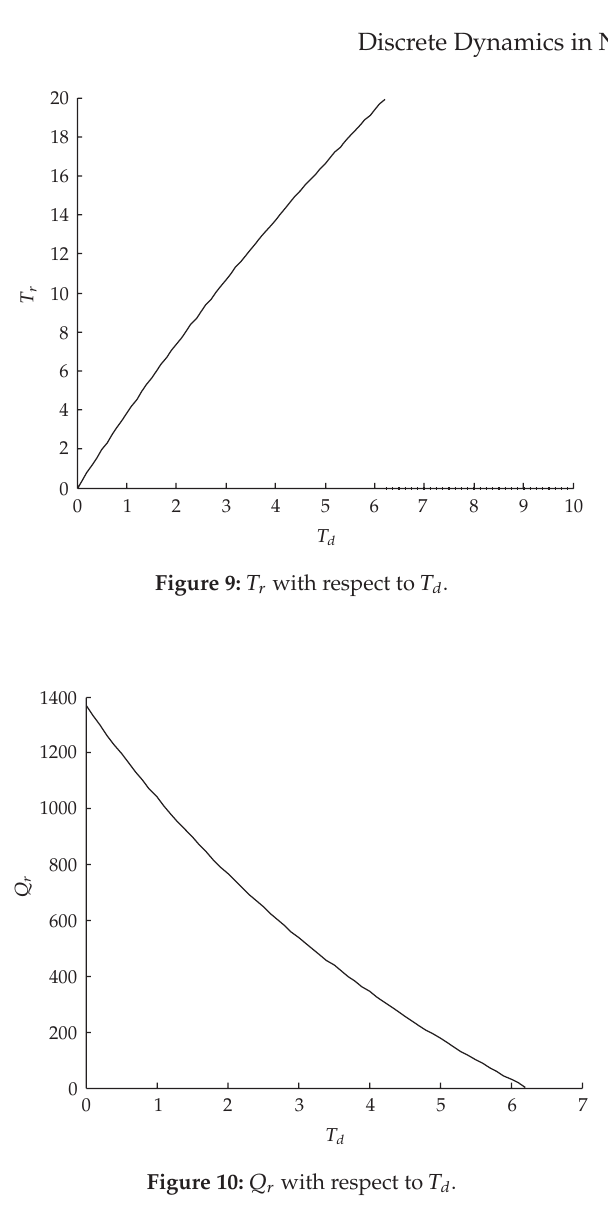
Figure 10: Q r with respect to T d